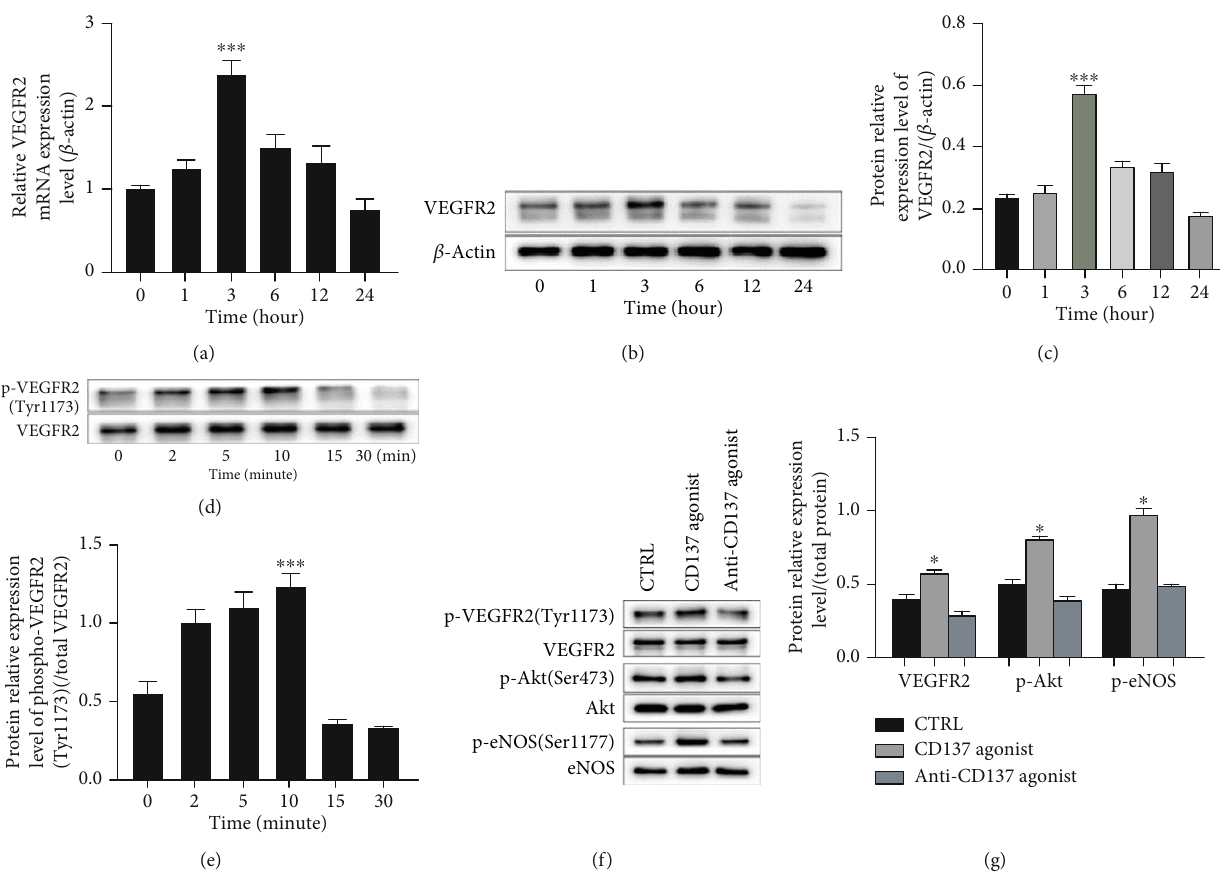
Figure 2: Activation of CD137 with CD137L in fl uences the expression of VEGFR2 and activates downstream Akt/eNOS. (a) The mRNA level of VEGFR2 by RT-PCR peaked at 3 hours after treatment with CD137L (10 μ g/ml) at 0, 1, 3, 6, 12, and 24 hours, respectively. (b) The VEGFR2 expression measured by western blot, and protein relative level standardized by β -actin (c). (d) Phosphorylated VEGFR2 (p - VEGFR2, Tyr1173, murine) at 0, 2, 5, 10, 15, and 30 minutes, and the relative protein expression normalized by total VEGFR2 (e). (f) p- VEGFR2, p-AKT, and p-eNOS were detected by western blot under activating and blocking the CD137 signal for 10 minutes and standardized by total protein, ∗ p < 0 : 05 , the CD137 agonist group compared with the control or anti-CD137 group (g). ∗∗∗ p < 0 : 001 , n = 3